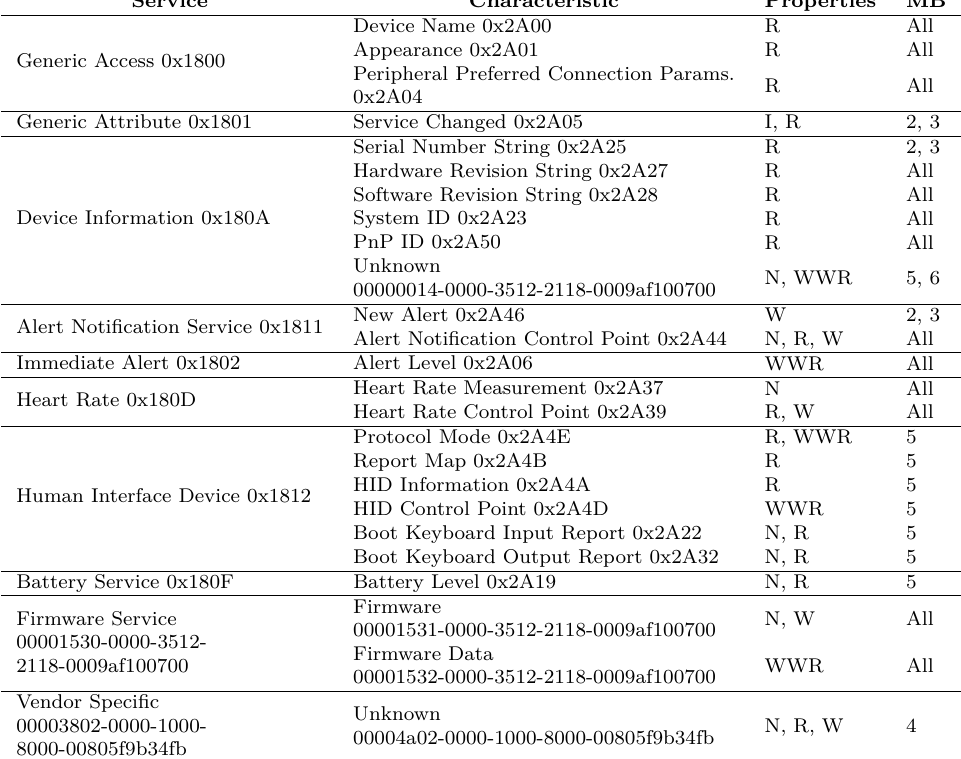
Table 6: Standard and vendor-specific services and characteristics exposed by every Mi Band GATT server. The first column shows the service name, and the second the characteristic name. The third column indicates the characteristic’s access control policy (R = read, W = write, WWR = write without response, N = notify, I = indicate). The last column indicates which Mi Band supports the current